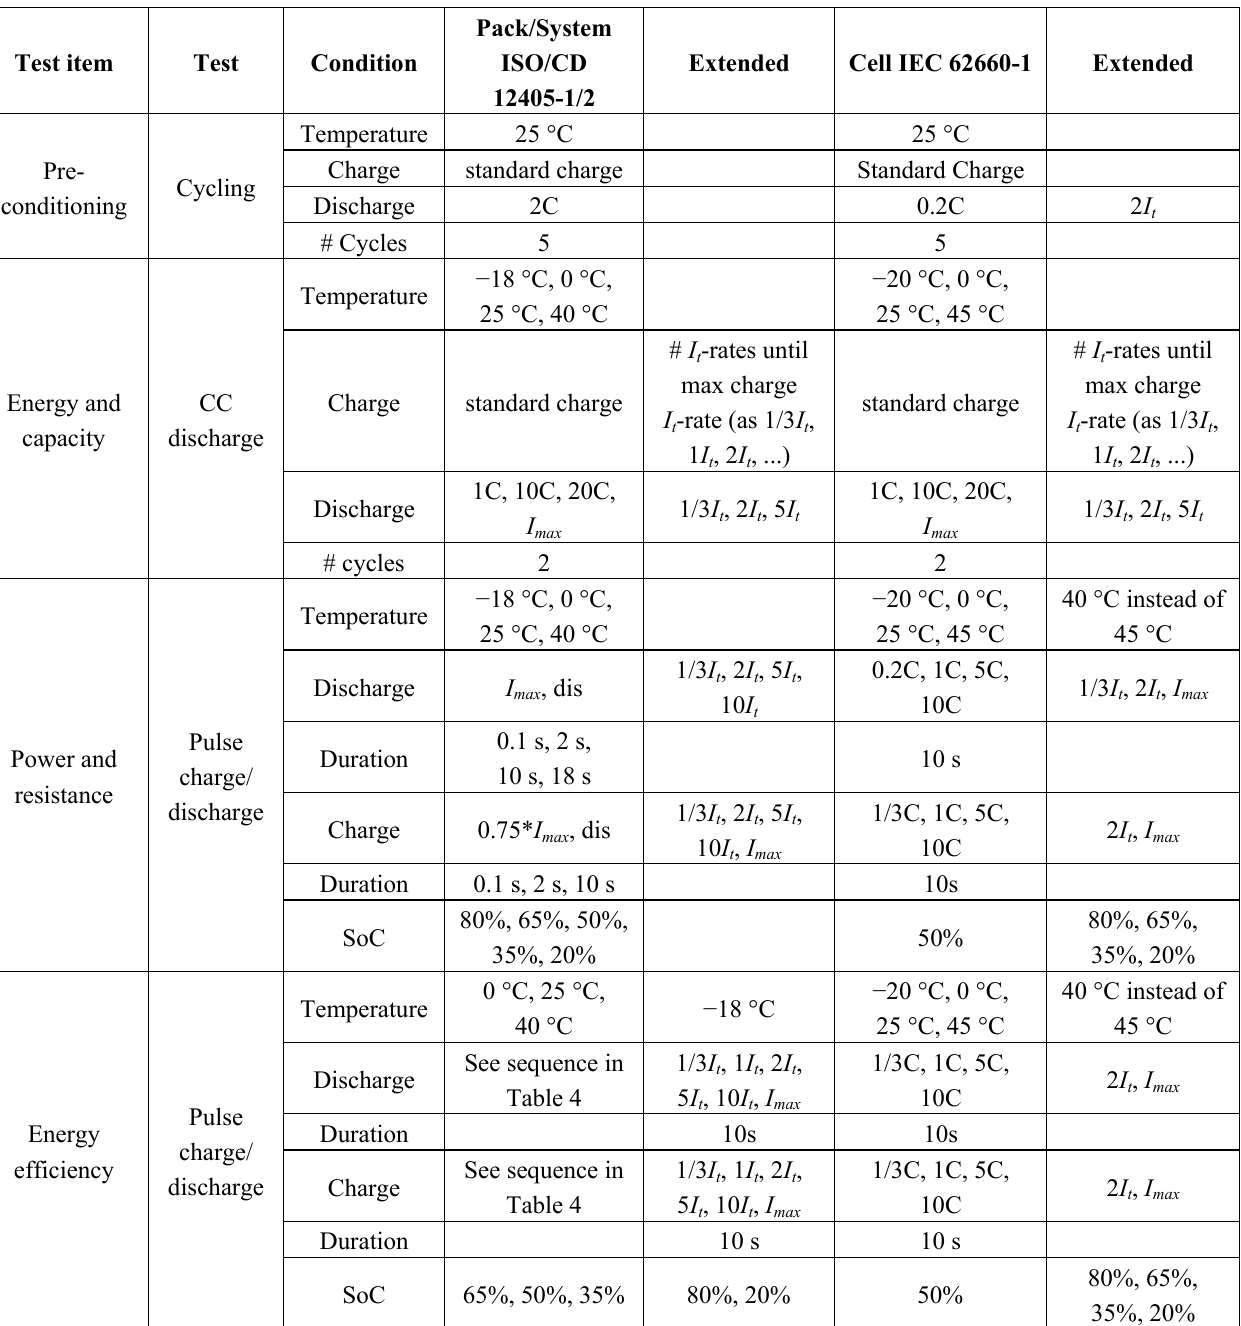
Table 1. Overview of the defined test in the standard ISO/CD 12405-1/2 and IEC